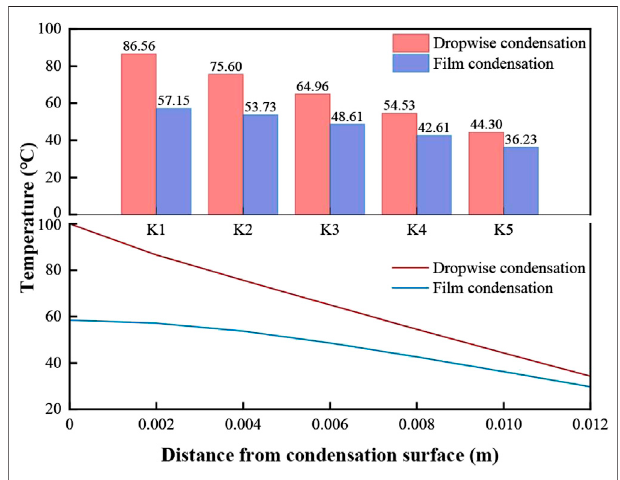
FIGURE 10 | Comparison of the temperature at each thermocouple in dropwise condensation and fi lm condensation.